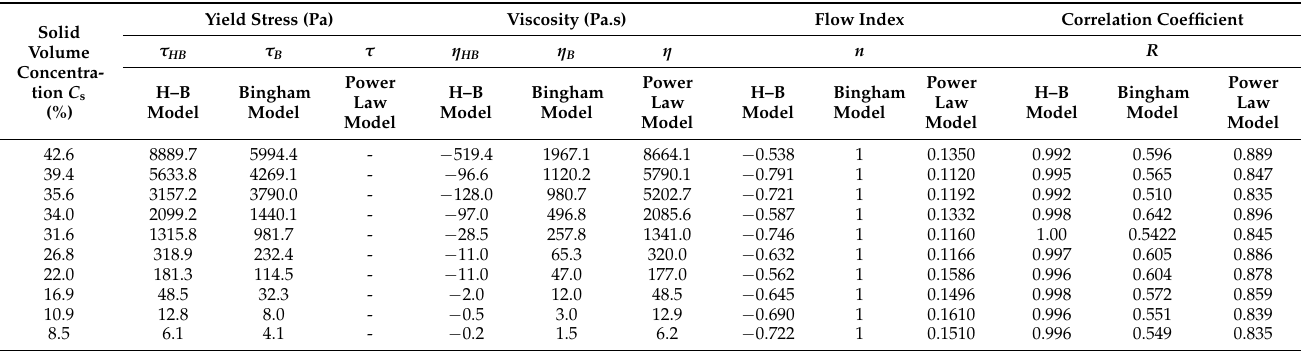
Table 2. Rheological characteristic parameters and correlation coefficients obtained by fitting rheolog- ical data of slurries with different solid volume concentrations (corresponding to the shear rate in the range of 0.01~2.0 s − 1 ) for the Chengdu clay